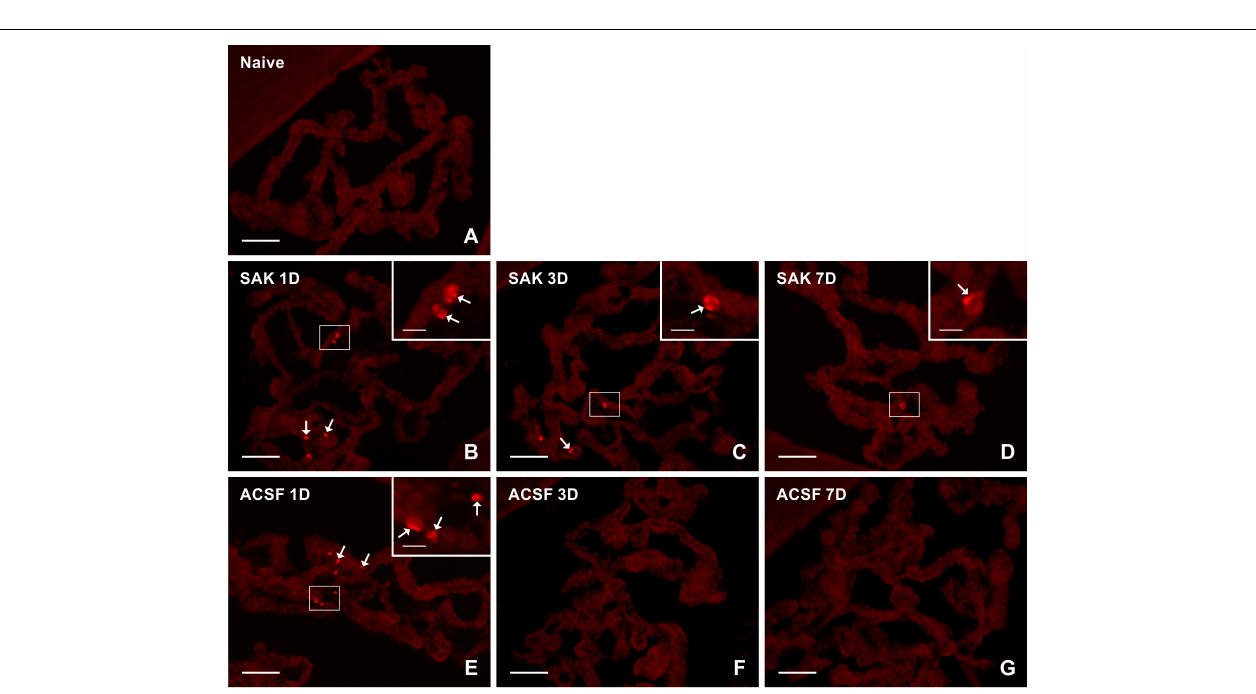
FIGURE 3 | Representative pictures showing results of immunostaining with CCR7 antibody in cryostat sections of the CP from naïve (A) , SAH (B–D) , and ACSF (E–G) rats at 1, 3 and 7 days (1D, 3D, and 7D) after operation. The number of CCR7+ cells was increased 1 and 3 days following induction of SAH and 1 day after ACSF administration. Arrows indicate CCR7+ cells in the epiplexus position of the CP. Insets show a higher magnification of regions marked by the boxes. Scale bars = 80 µ m (main image); 10 µ m (insets).